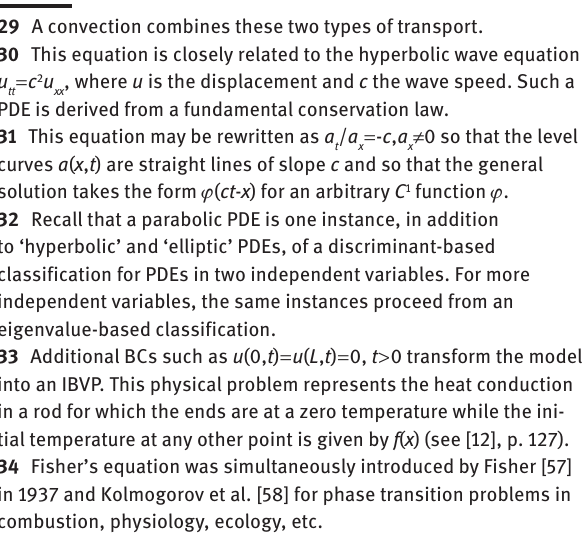
Figure 4 Mathematica ® implementation of DDEs with constant